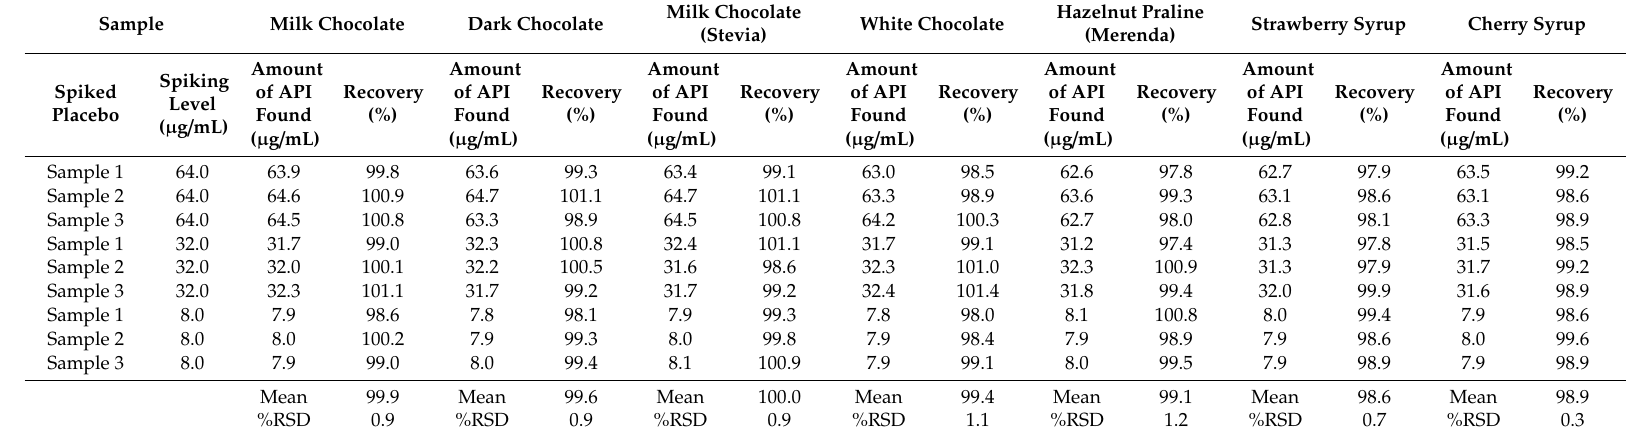
Table 2. Accuracy data for active pharmaceutical ingredient (API) (spiked placebo